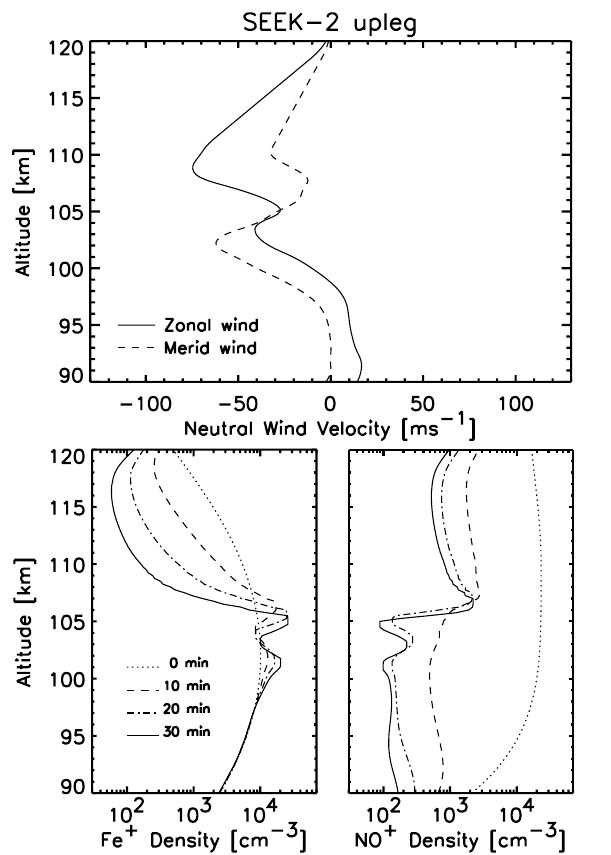
Fig. 2. Same as top and middle panels of Fig. 1 but for the upleg of the SEEK-2.